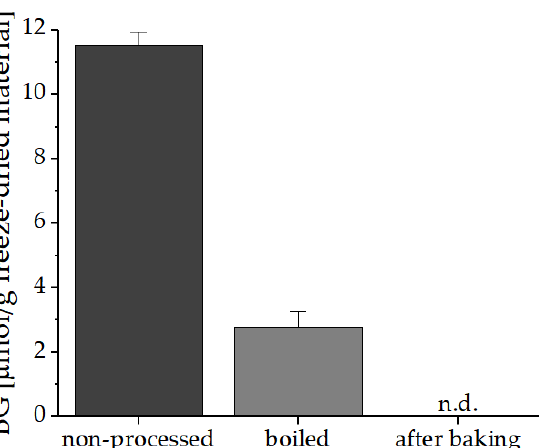
Figure 4. Thermal degradation of GLS in nasturtium after boiling in water for 10 min to deactivate the myrosinase and further baked into bread. The experiment and analysis were performed in duplicate. Abbreviations: BG: benzyl glucosinolates, n.d.: not detected.